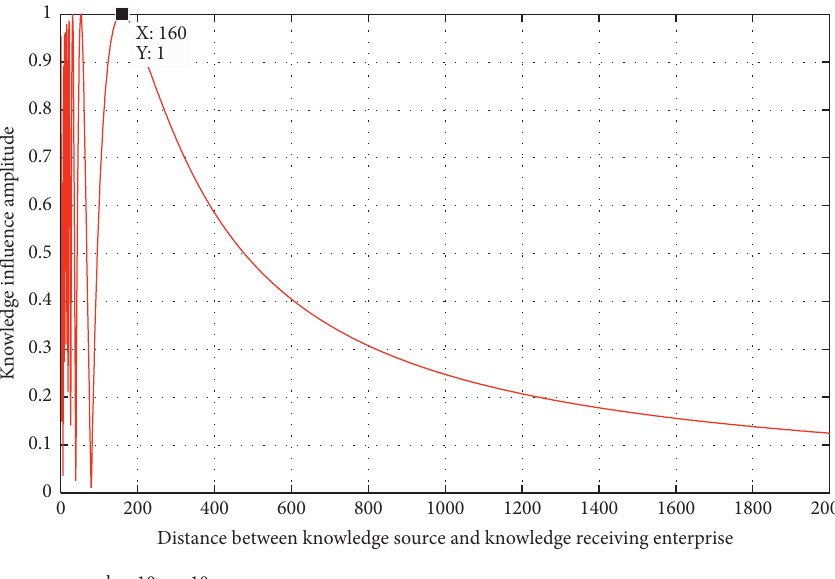
Figure 7: Distribution of the influence amplitude in the knowledge field when the alliance is large and the transfer efficiency is